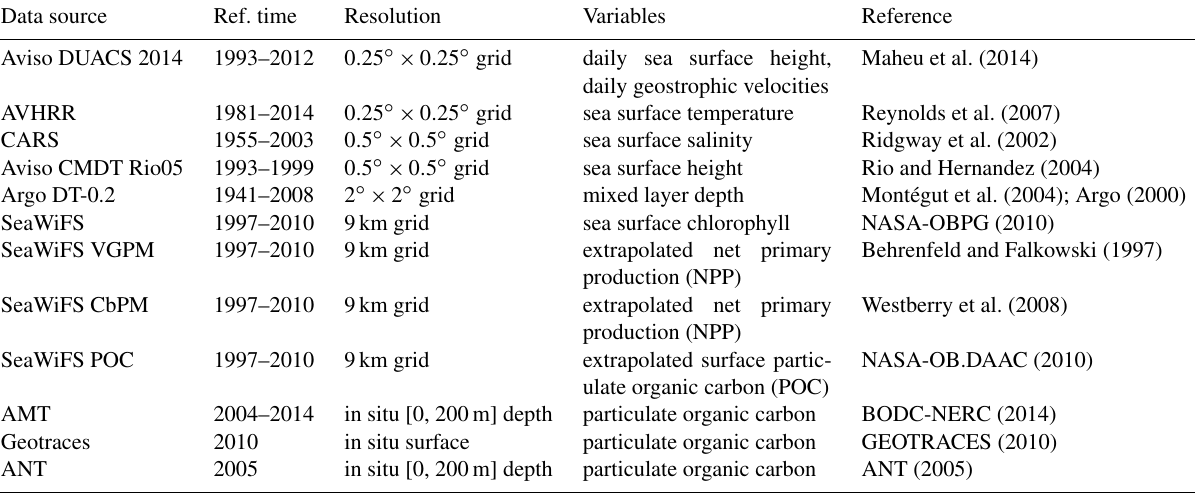
Table A1. Description of the datasets used for the model evaluation. CMDT: Combined Mean Dynamic Topography; AVHRR: Advanced Very High Resolution Radiometer; CARS: CSIRO Atlas of Regional Seas; SeaWiFS: Sea-viewing Wide Field-of-view Sensor; WOD09: World Ocean Database